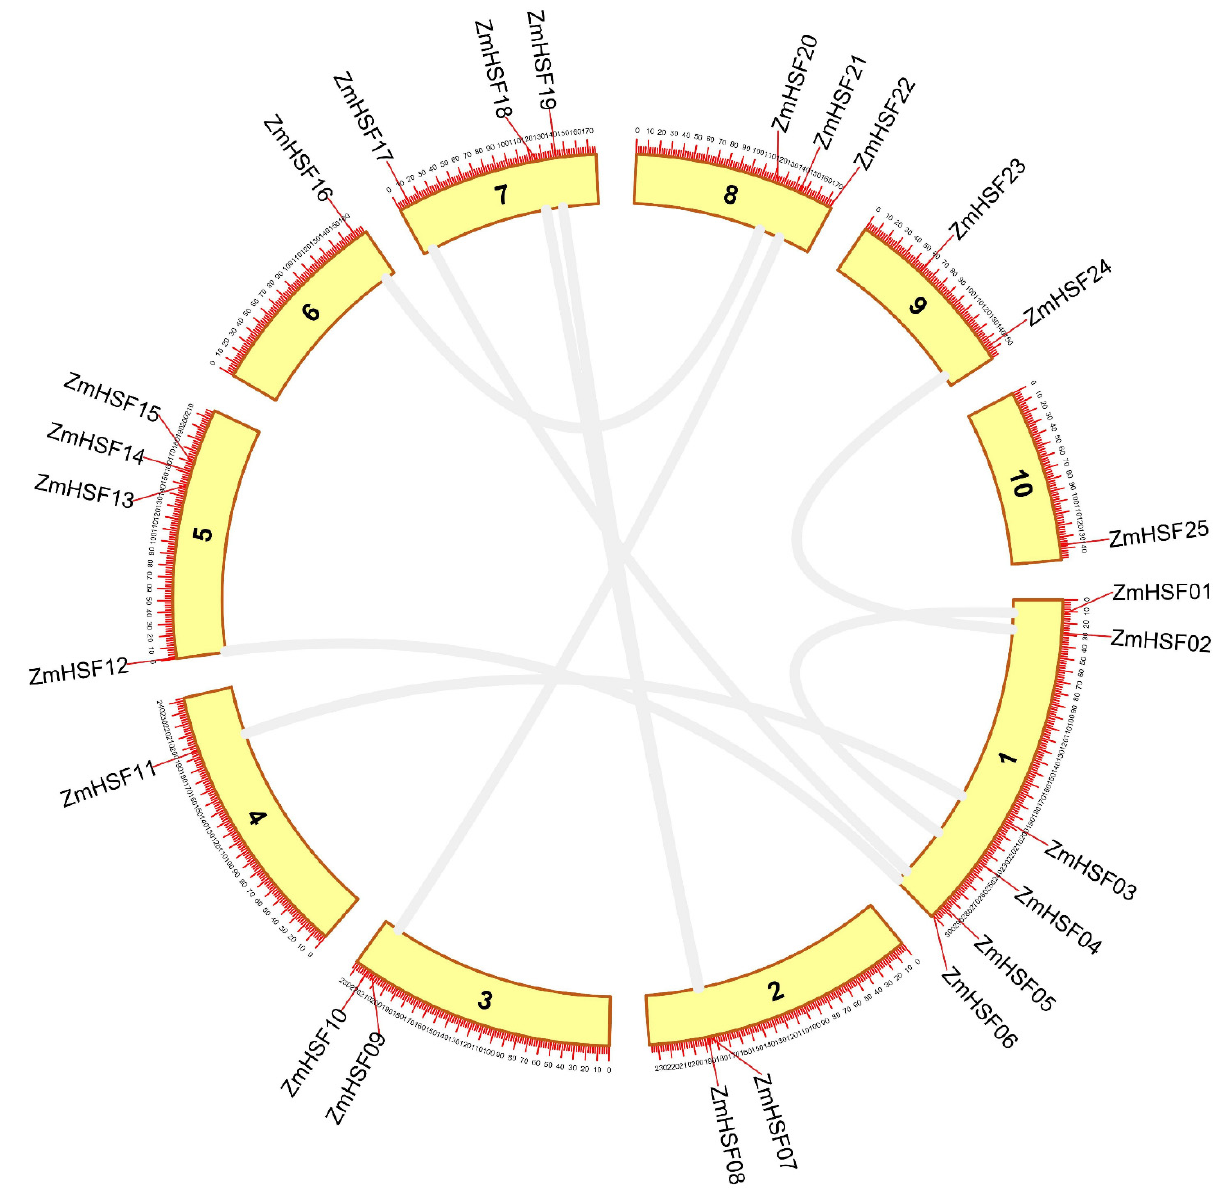
Figure 3. Circular illustration of the maize genome. The paralogous HSF genes are connected with grey lines. The red lines on top of the chromosomal bar represent the position of HSFs.